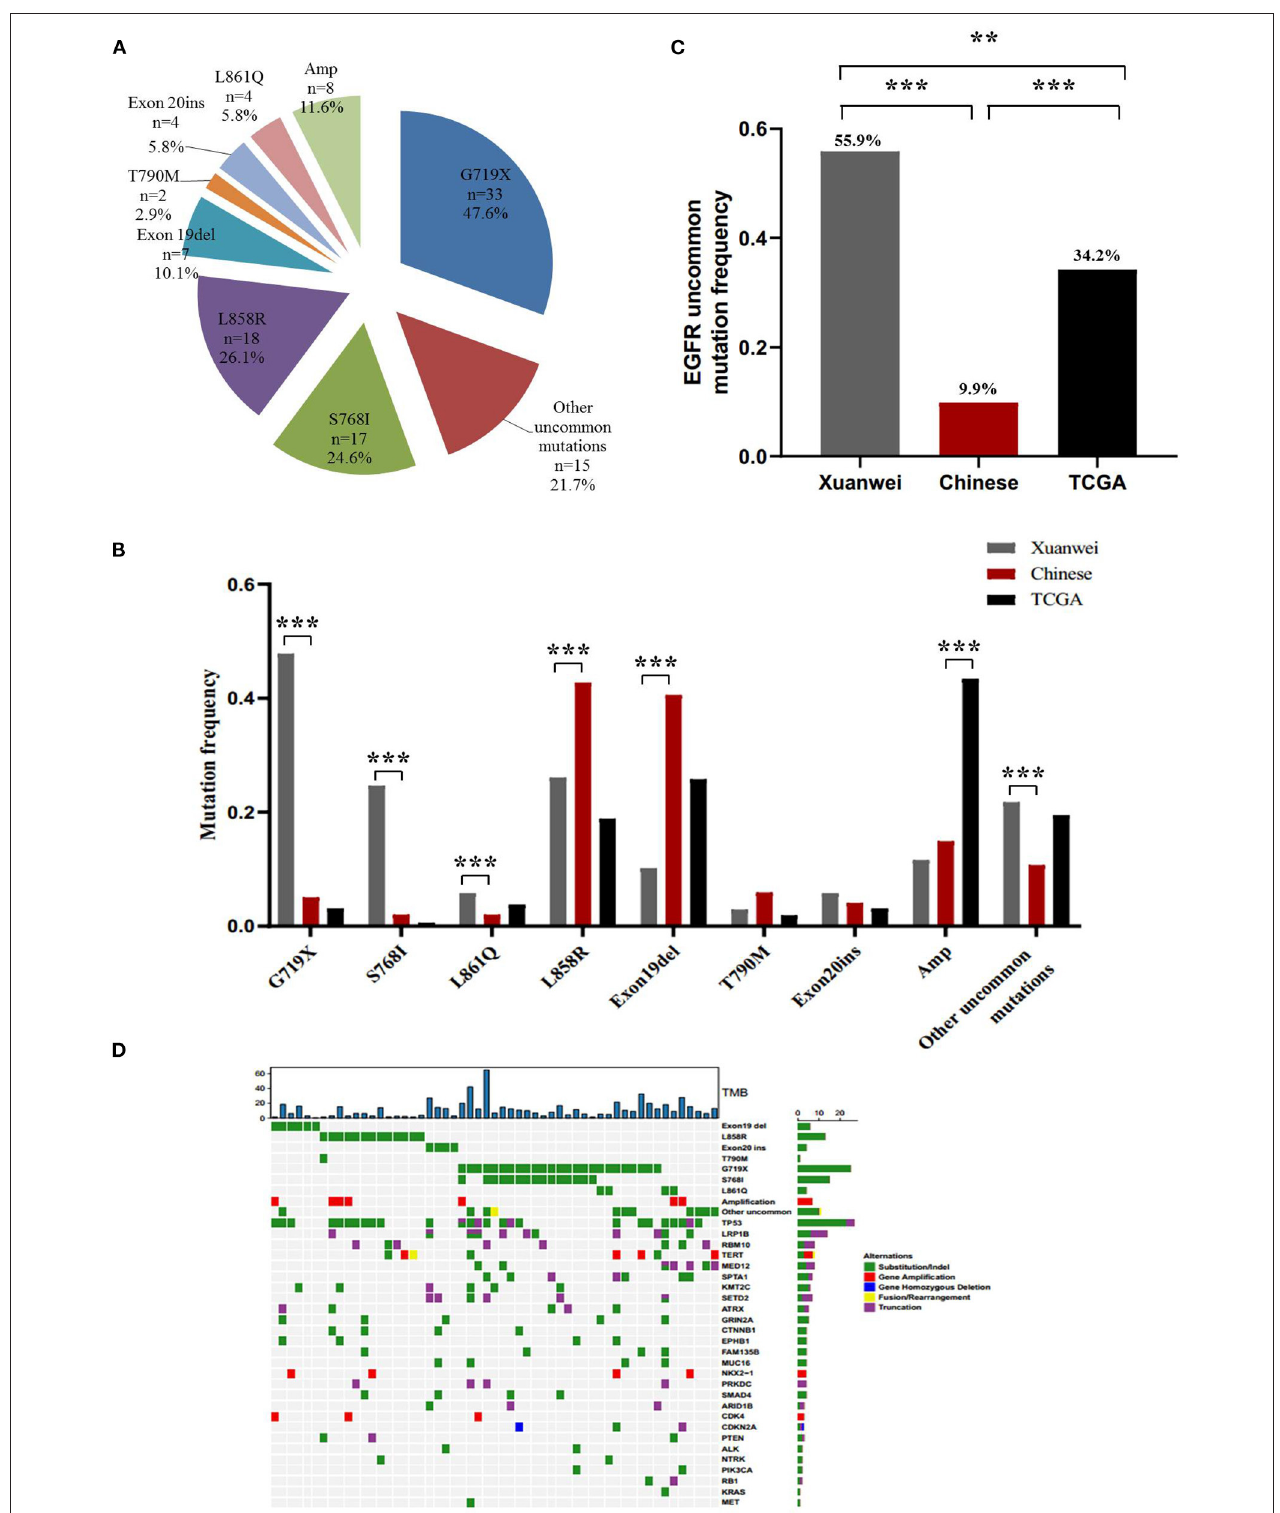
FIGURE 2 | EGFR mutation spectrum in the Xuanwei, reference Chinese, and TCGA NSCLC cohorts. (A) EGFR mutation subtypes of patients from Xuanwei. (B) Comparison of EGFR mutation profile among the three groups. (C) Ratio of uncommon EGFR mutations in the three groups. (D) Mutation profiles of patients from Xuanwei with EGFR genomic alterations. Mutant frequencies in the cohort are shown on the right. TMB for each patient is shown at the top. *** p < 0.001, ** p < 0.01, and * p < 0.05.